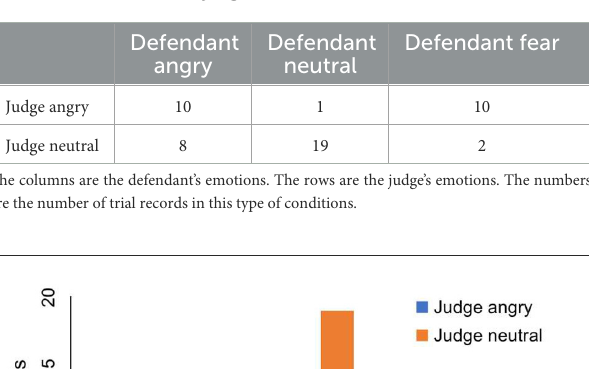
TABLE 2 The influence of plaintiff’s emotion on defendant’s emotion.